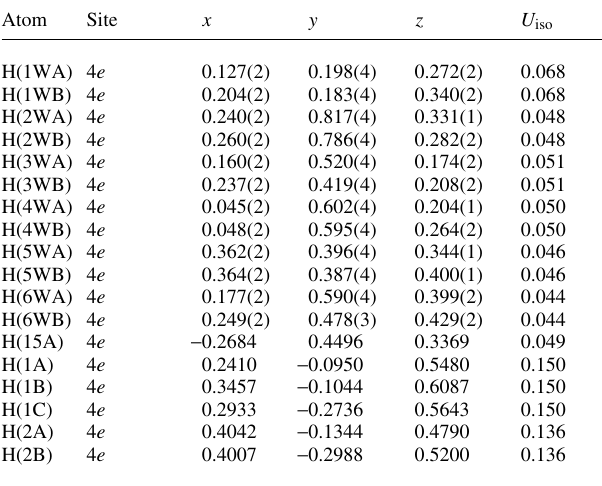
Table 2. Atomic coordinates and displacement parameters (in Å 2 )